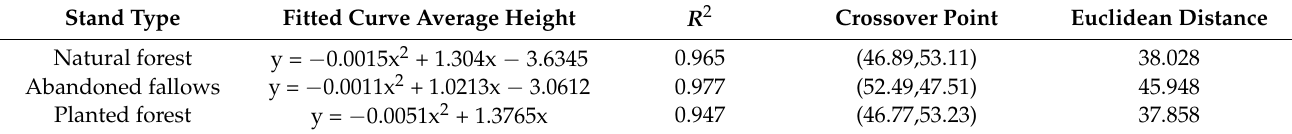
Table 8. Changes in stability parameters in relation to stand